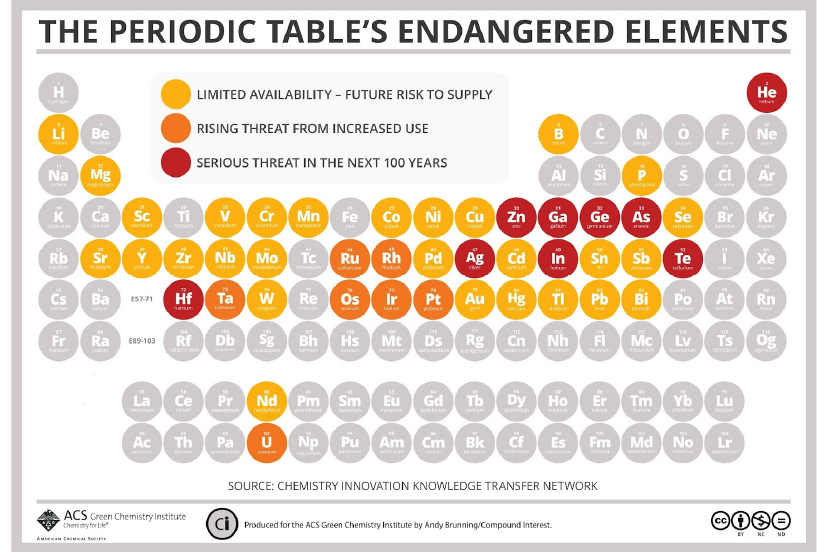
Figure 5. Periodic Table’s endangered elements.